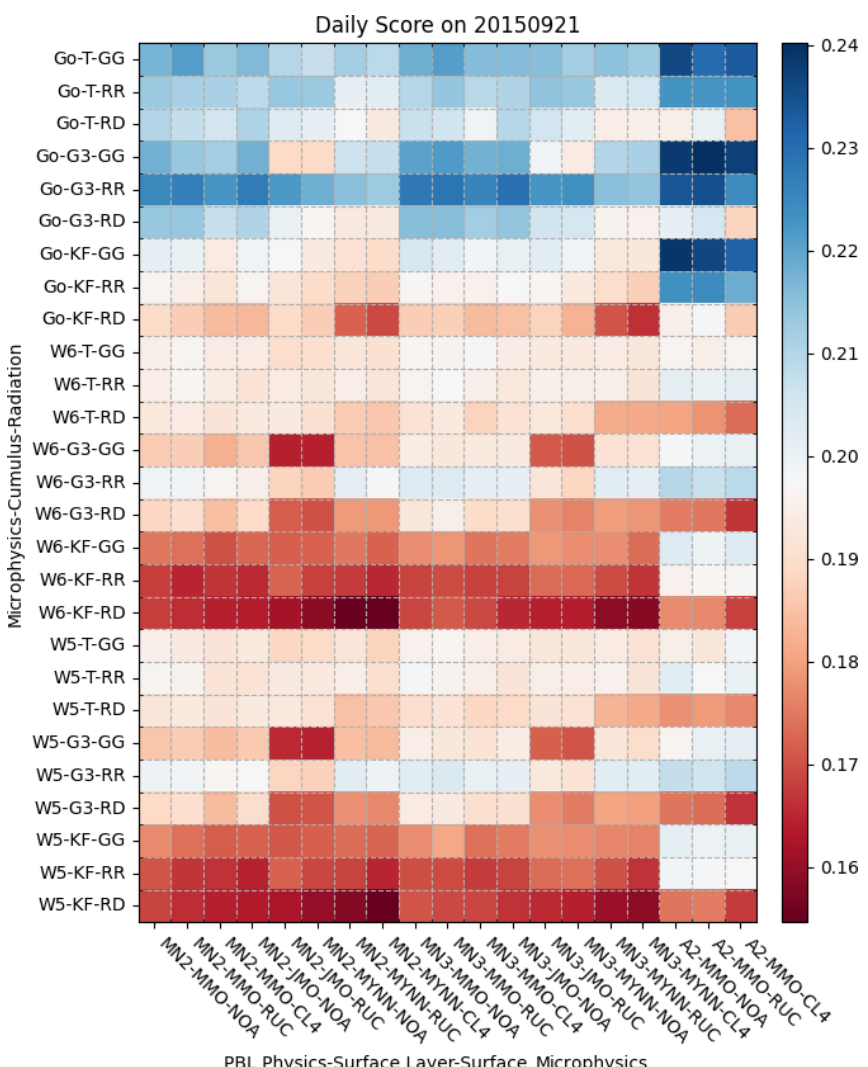
Figure 12. The heat map of the average κ for the configuration for the clusters of microphysics, cumulus parameterization, and the radiation physics ( y axis) with the cluster of PBL physics, surface physics, and the land surface model ( x axis) for the simulation case on 21 September for Set 2. The data only use the last 36h of simulations for calculating κ